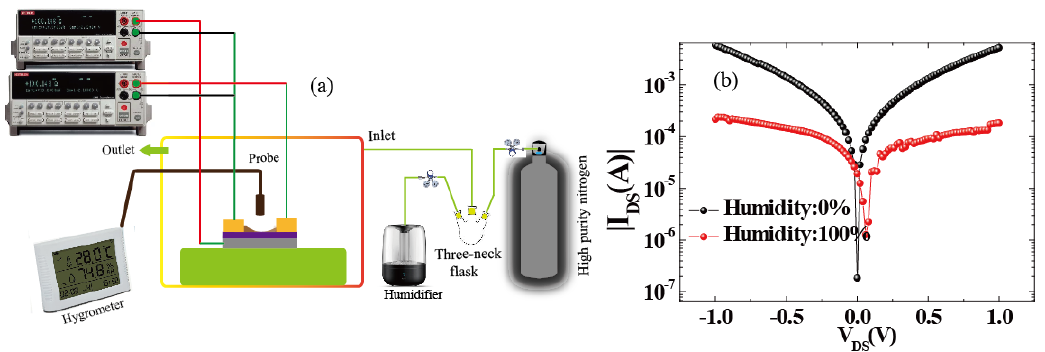
Figure 2. ( a ) Testing equipment used for the electrical characterization of 3DGF humidity sensors. ( b ) Output characteristic of the device decorated with or without water molecules.